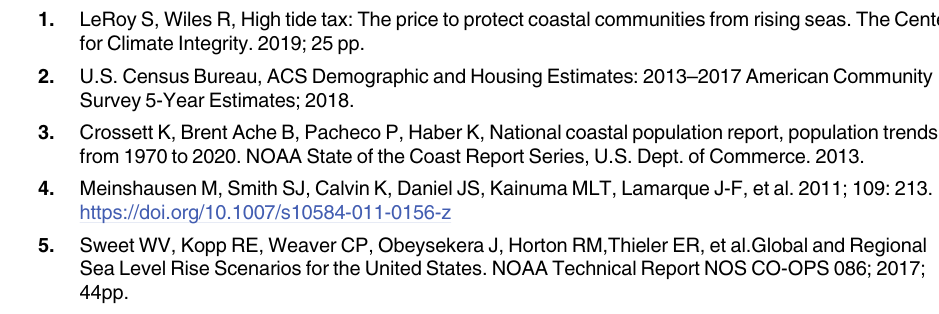
S1 Fig. Base map of Charleston peninsula. S2 Fig. Phase plane plots of observed and predicted monthly mean water levels. S3 Fig. Comparisons of model and NOAA predicted and verified hourly water